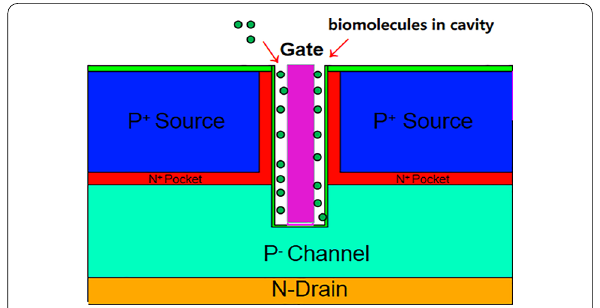
Fig.1 Schematic cross-sectional view of DM-DSTGTFET